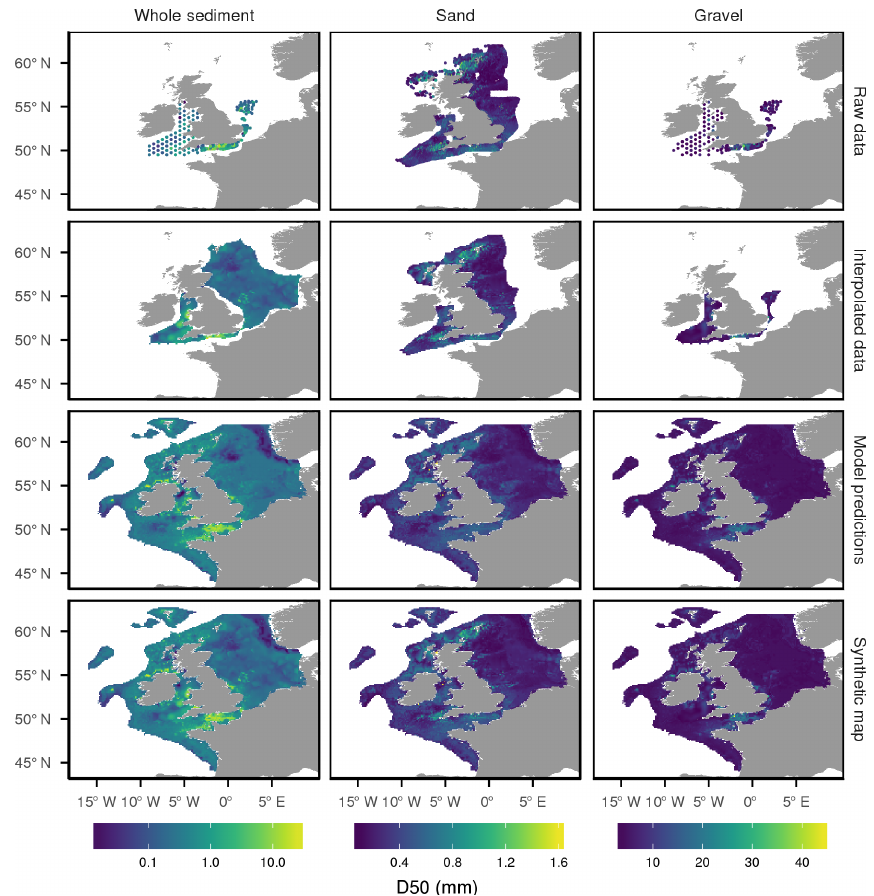
Figure 7. Summary of the derivation of the synthetic median grain size maps. Where we have sufficient median grain size data we spatially interpolated a map of D 50 . In other locations we used the synthetic map of mud, sand and gravel percentages and a GAM which relates the D 50 to the mud, sand and gravel percentages to predict the D 50